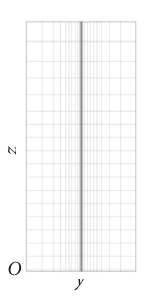
Figure 10: Mesh diagram of the model.